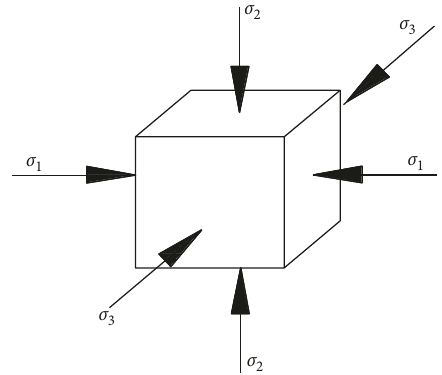
Figure 5: Mine rock unit compressed from three directions.